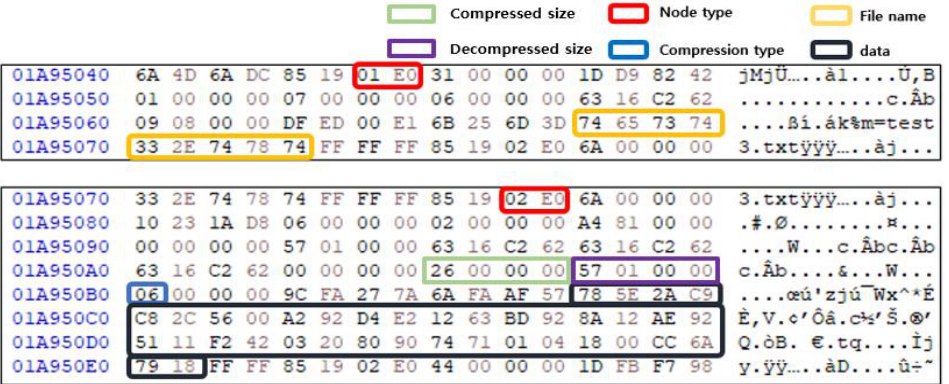
Figure 18. Dirent node ( top ) and inode ( bottom ) of ‘test3.txt’ file.